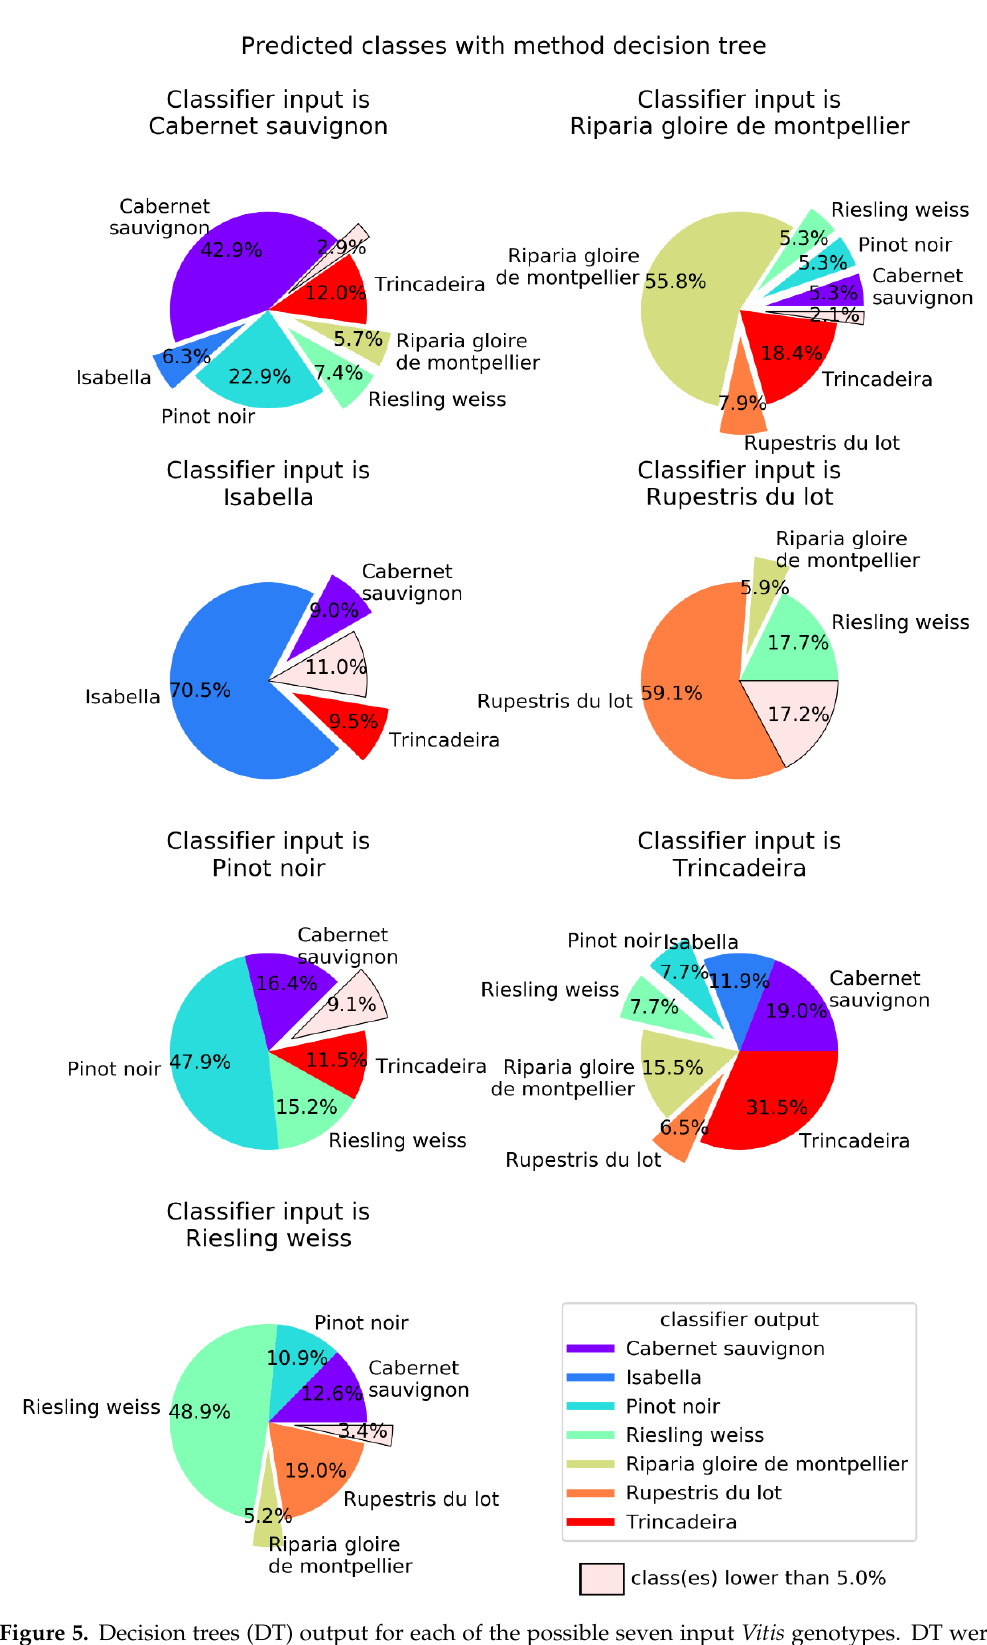
Figure 5. Decision trees (DT) output for each of the possible seven input Vitis genotypes. DT were defined using the entropy criterion, a maximum depth of 19 and a minimum number of samples of five. Global success rate is 51.6%.